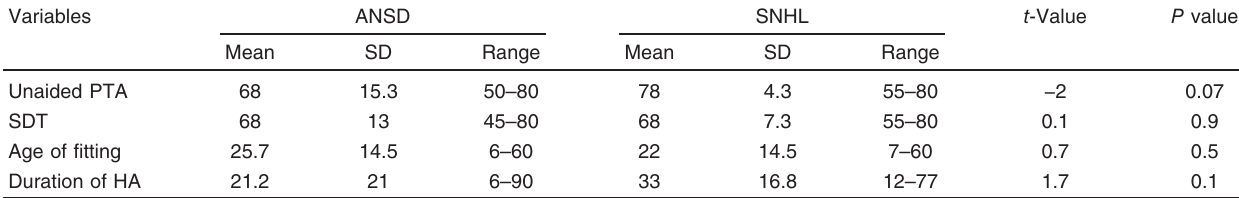
Table 2 Student ’ s t -test between the auditory neuropathy spectrum disorder and sensorineural hearing loss groups Variables